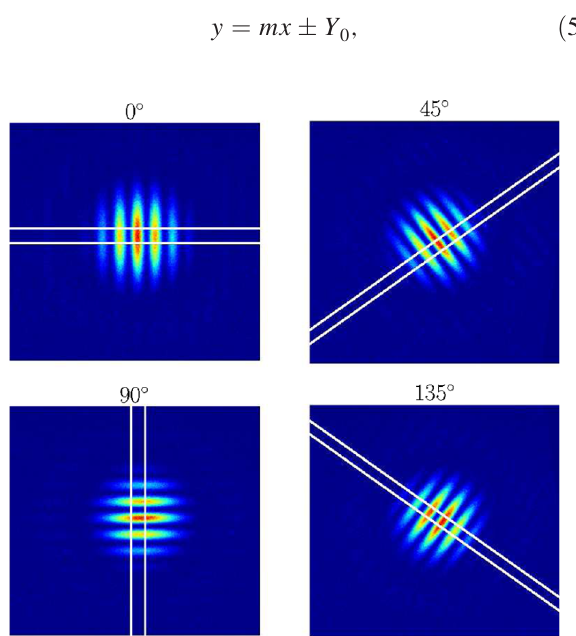
FIG. 5. Interferograms rotated at 0°, 45°, 90°, and 135° to measure the size of the projection of the beam along the respective axis. White lines are oriented in the direction of the pinholes axis, rotated at angle θ , and represent the slices selected for the fitting process.